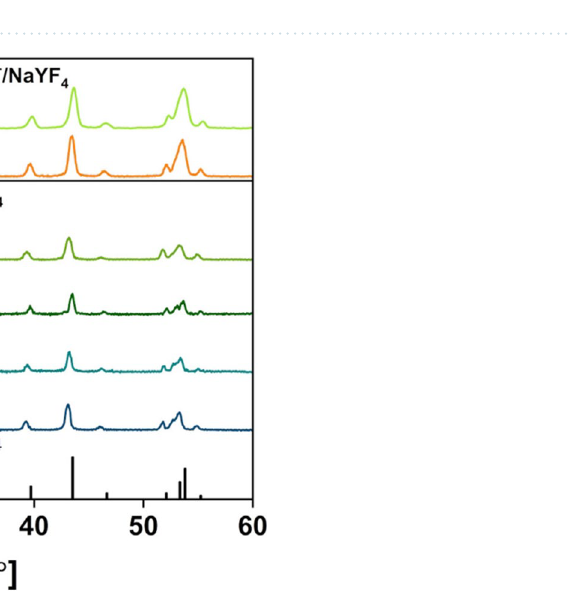
Figure 1. Schematic representation of the synthesis and ligand-free modification of OA-capped NaYF